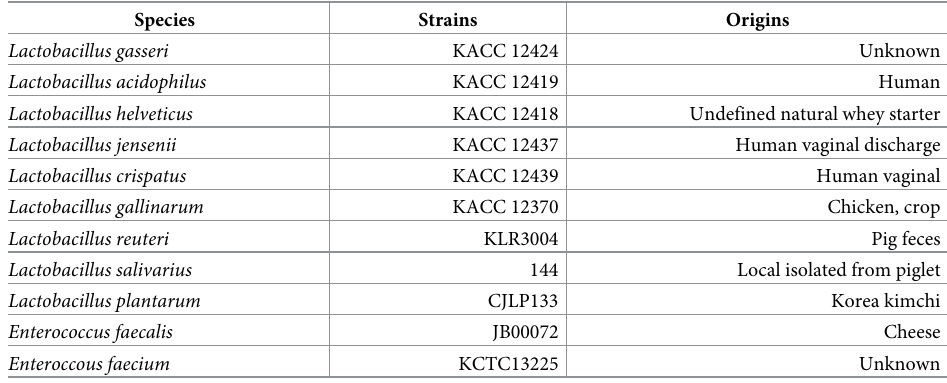
Table 1. Bacterial strains used for the multiplex PCR optimization. Species Strains KACC 12424 Unknown KACC 12419